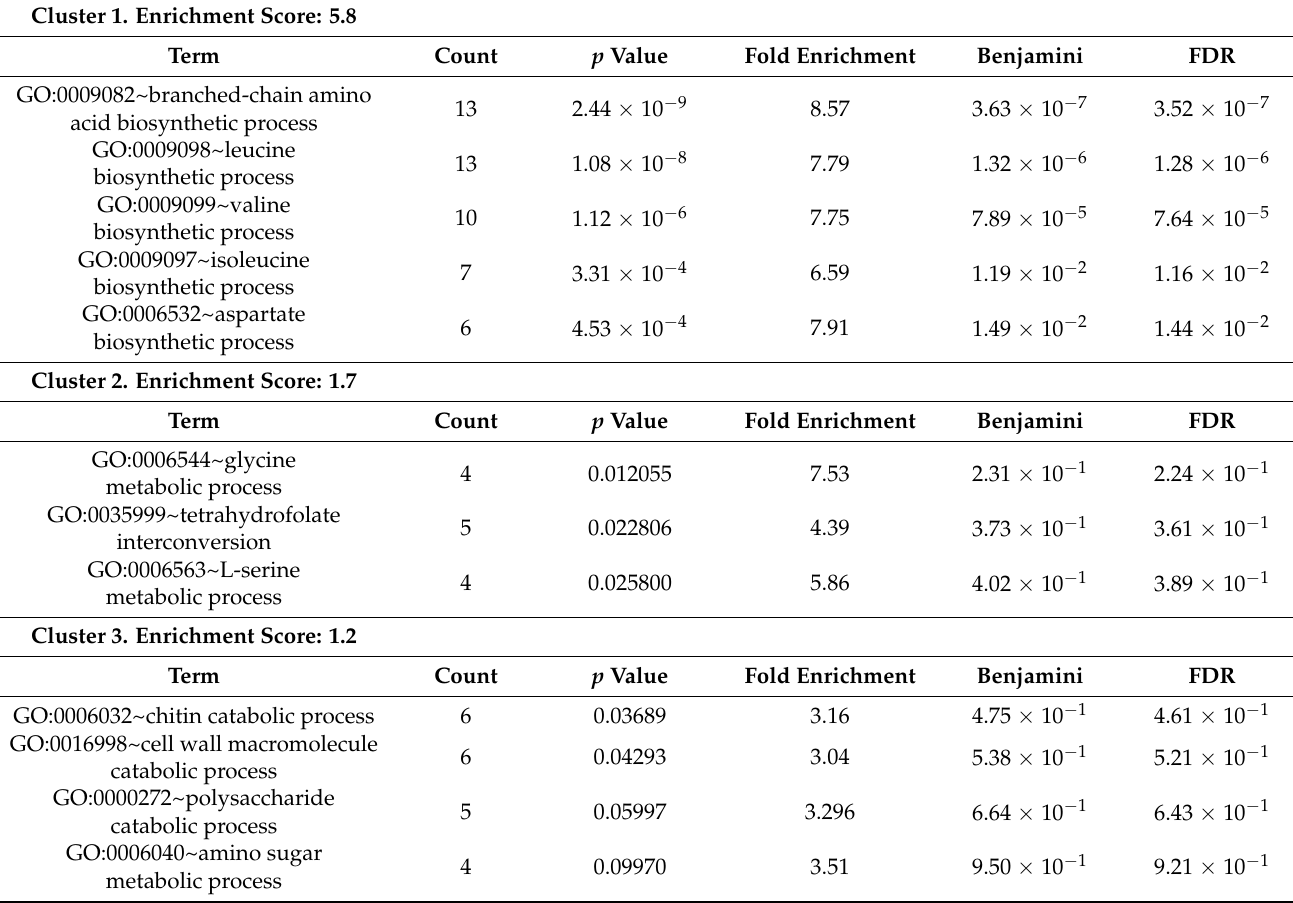
Table 1. Functional annotation clustering of the differentially persulfidated